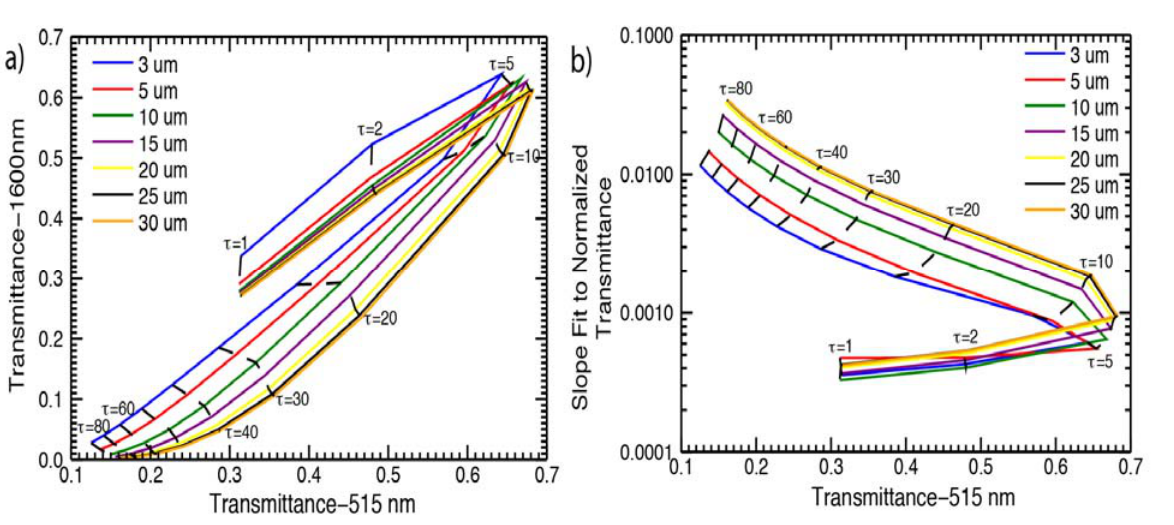
optical thickness lines. Calculations are for μ